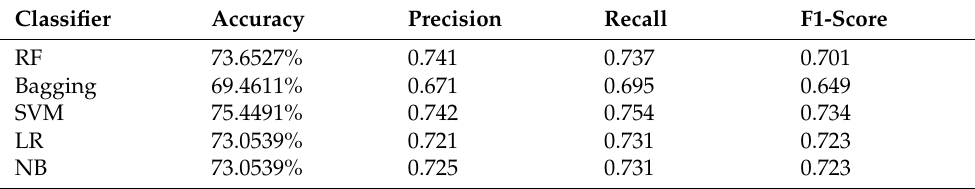
Table 12. Experiments with ML models and concatenated features on original sentiments.